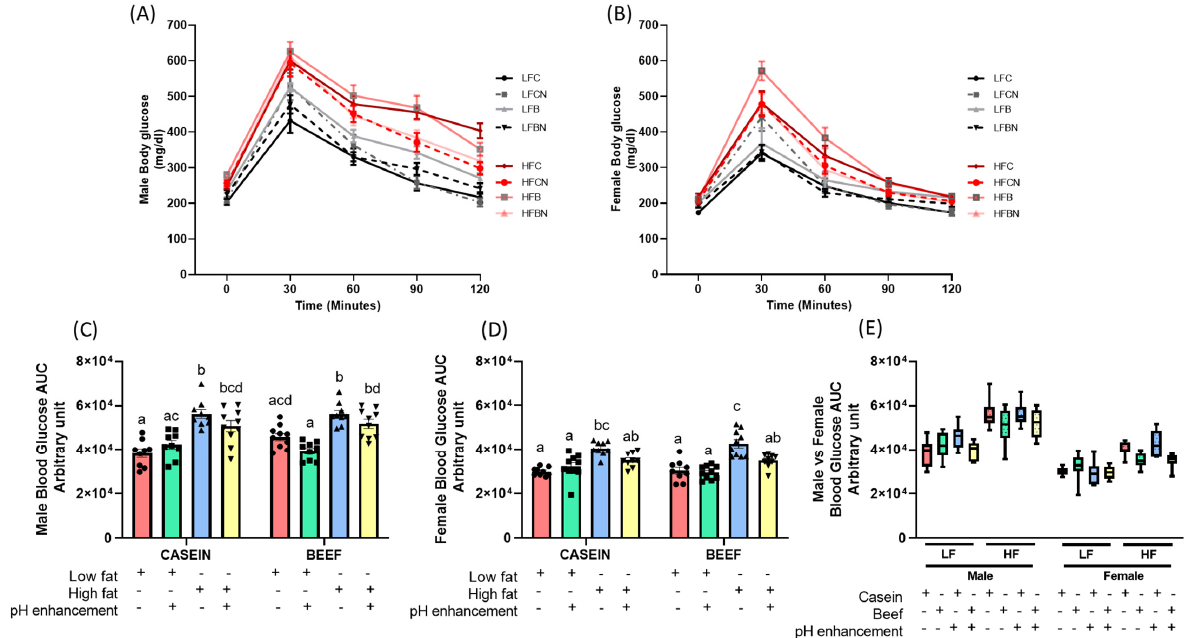
Figure 5. Role of diet, protein source, pH enhancement and sex in glucose clearance in diet induced obese male and female mice. ( A , B ) Glucose tolerance test (GTT) in male and female mice. ( C , D ) Area under the curve (AUC) for GTT in male and female mice. ( E ) AUC male vs. female. Data is presented as mean ± SEM. LFC, low fat casein; LFCN, low fat casein pH enhanced; LFB, low fat beef; LFBN, low fat beef pH enhanced; HFC, high fat casein; HFCN, high fat casein pH enhanced; HFB, high fat beef; HFBN, high fat beef pH enhanced. Common letters on the error bars indicate no significance (e.g., “a” is significantly different from “b” and “ab” indicates no significance compared to “a” and “b”). p < 0.05; n = 8–10.